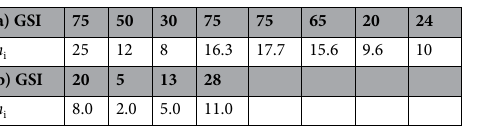
Table 4. Values of m i with different GSI: (a) Hoek and Brown 33 ; (b) Hoek and Marino 36 .